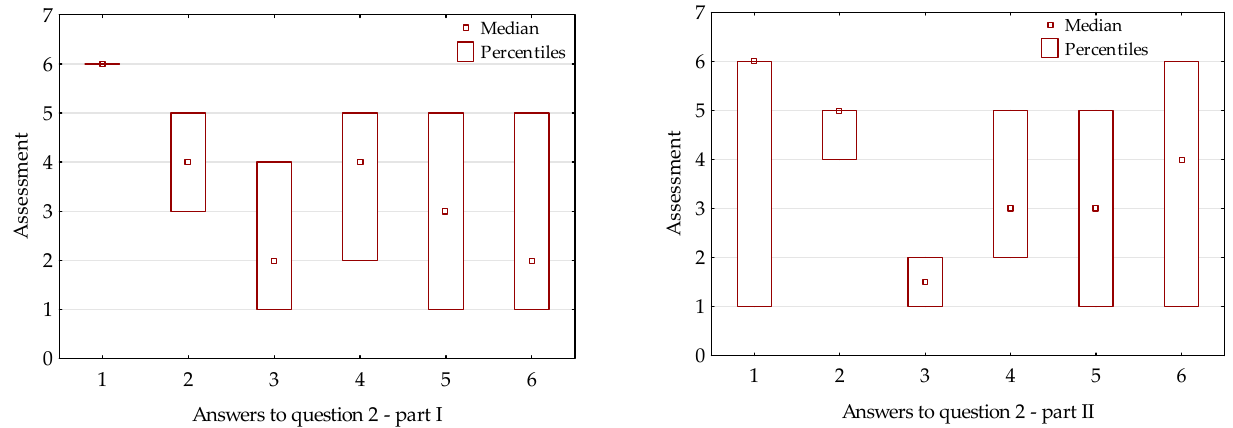
Figure 2. Box-whisker charts for the mean ranks of the assessed answers in question 2 for the accuracy of answers criterion ( part I ) and the criterion of the answer structure ( part II ).